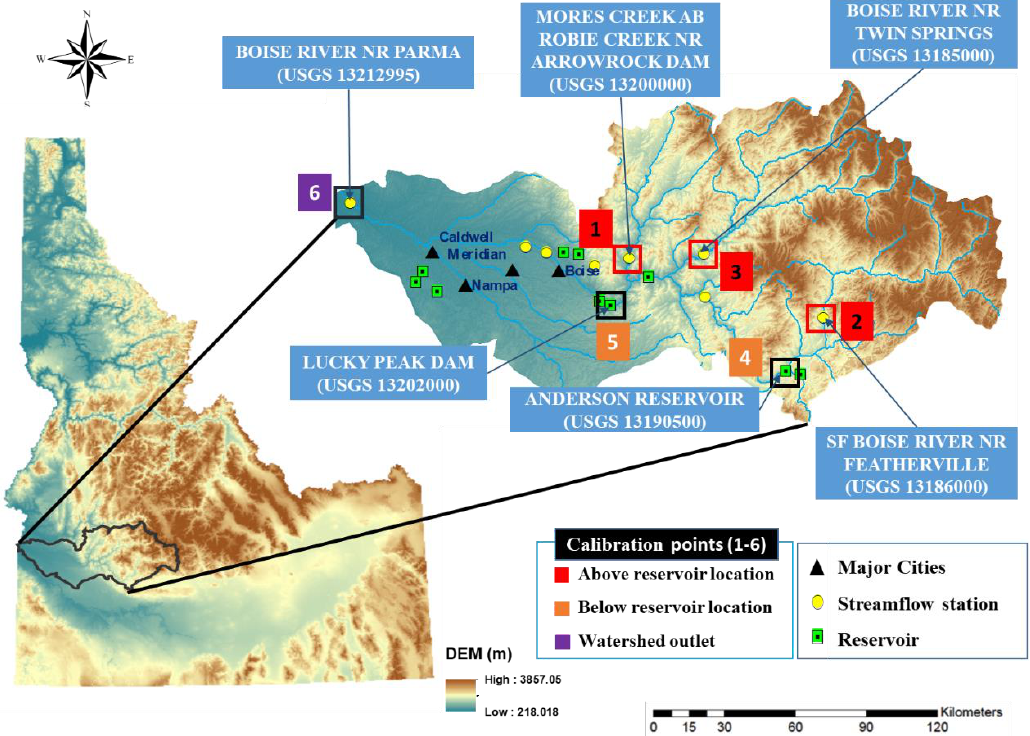
Figure 1. The map of the Boise River Watershed (BRW).